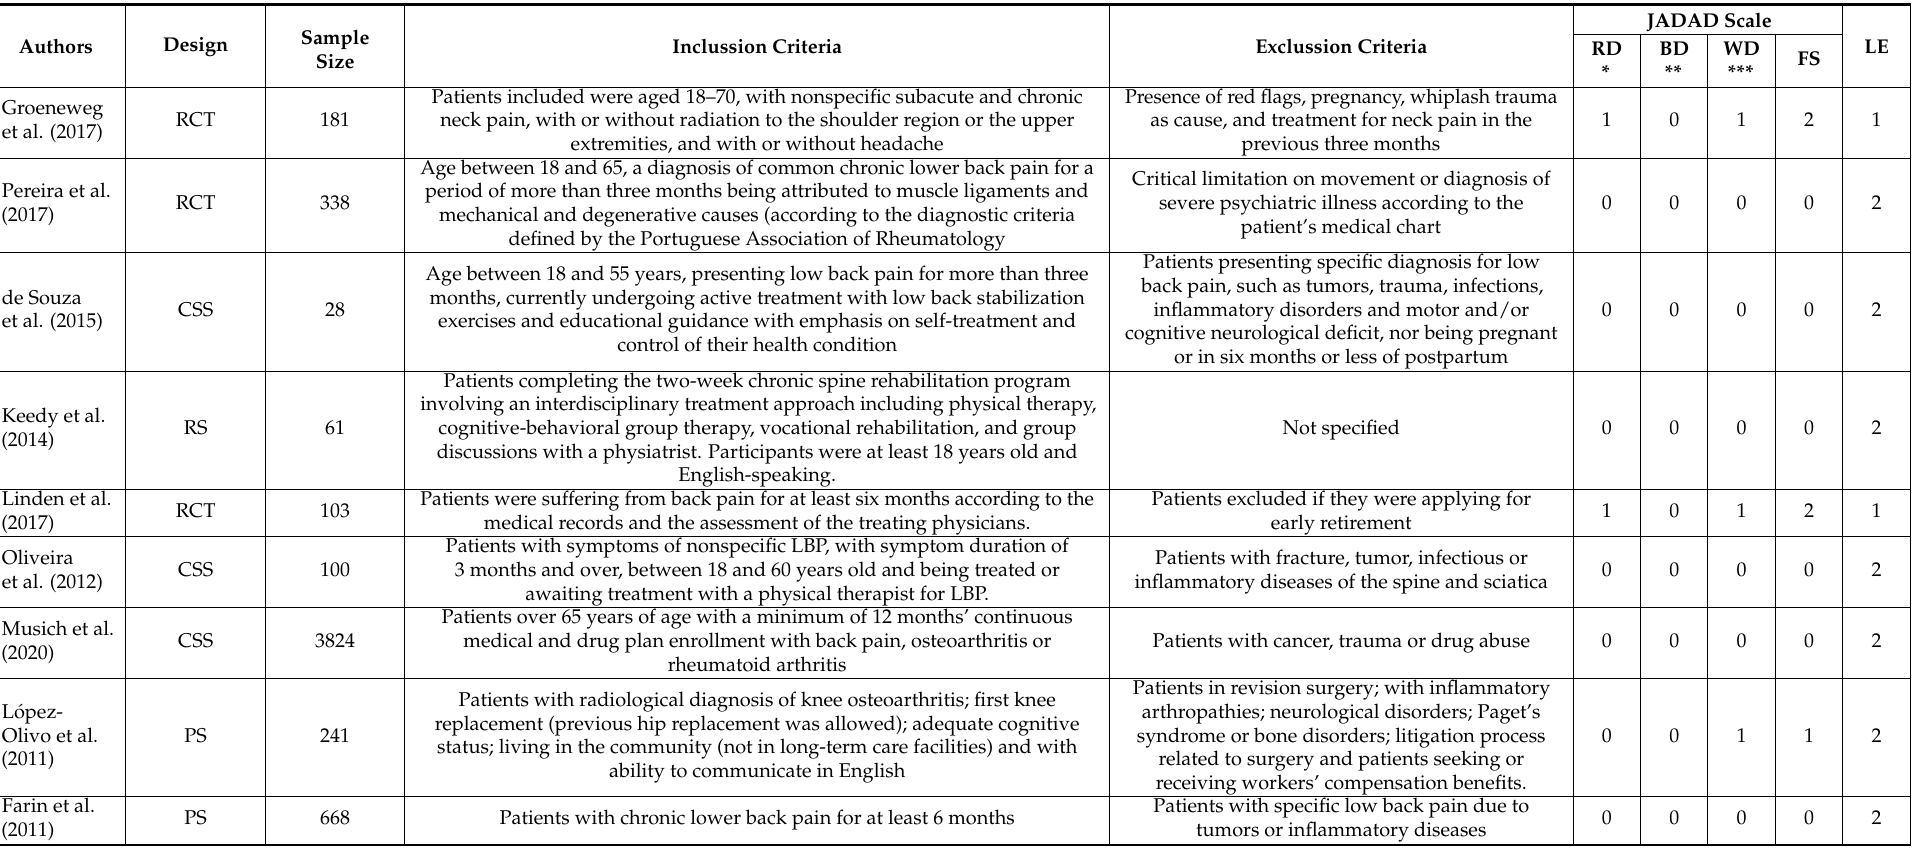
Table 2. Methodological characteristics of the studies